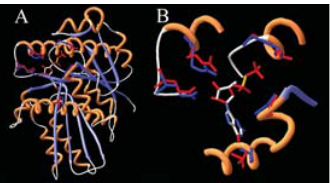
Figure 4 - FtsZ structural model for M. synoviae . (A) Cartoon representa- tion of FtsZ theoretical model and its GTP/GDP binding site. Amino acids that interact through hydrogen bonds with GTP/GDP are shown. The long C-terminal tail in FtsZ from M. synoviae is not shown. (B) Comparison of interacting amino acids from FtsZ with GTP/GDP molecule; Red amino acids (G21, G22, G107, T108, E138, R142 and N185) are those from the M. synoviae protein; Blue amino acids (G21, G22, G108, T109, E139, R143 and D187) are those from the Pseudomonas aeruginosa protein (1OFU). There are no significant differences in spatial configuration nor amino acid